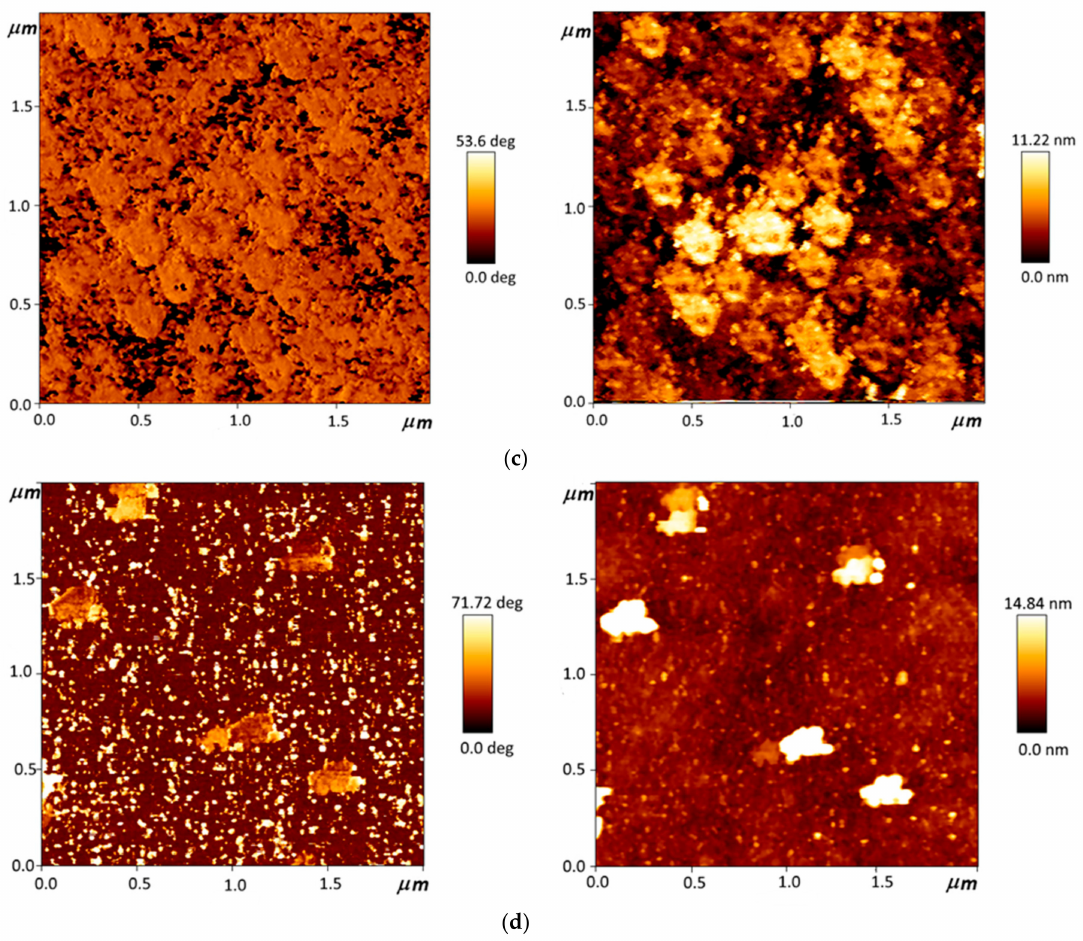
Figure 4. Atomic force microscopy (AFM) images of DLC:Cu samples containing di ff erent amount of copper: 22.48 at.% Cu ( a ), 32.45 at.% Cu ( b ), 48.36 at.% Cu ( c ), 58.47 at.% Cu ( d ). Phase images are presented at the left and morphology images are at the right.